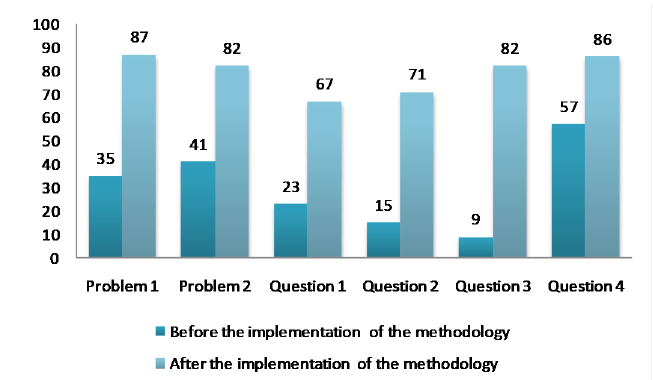
Figure 14: Visualization of data received before and after the implementation of the methodology with the use of the “Virtual Model of Identifying the Risks for Locomotor Apparatus Caused by Ligament Stretching” software